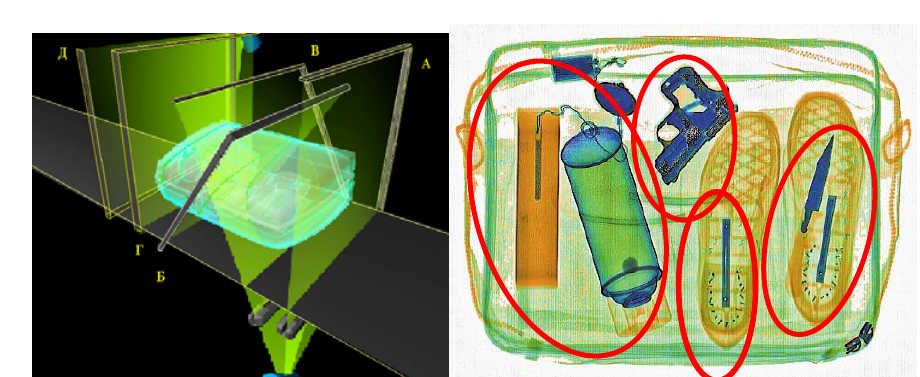
Figure 14 – X-ray multi-energy ventilation through five angles and the images of the detected prohibited items (marked: an improvised explosive device, a gun, a detonator, and a two-part knife)